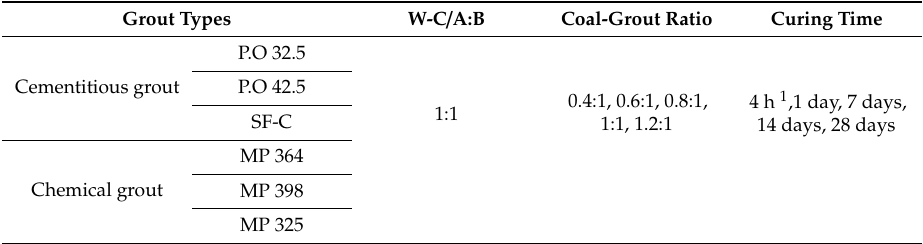
Table 2. Experimental design of coal-grout